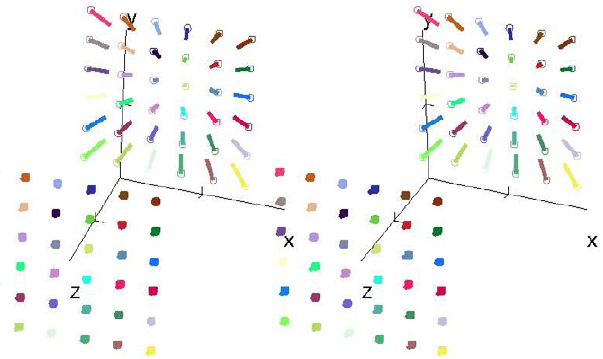
Figure 7. Stereo-pair scatter plot of the ray vectors traversing the cornea of Subject 2 in three-dimensions. Again the z-axis represents the optical axis and the separation between the en- trance and exit planes is exaggerated for ease of inspection.